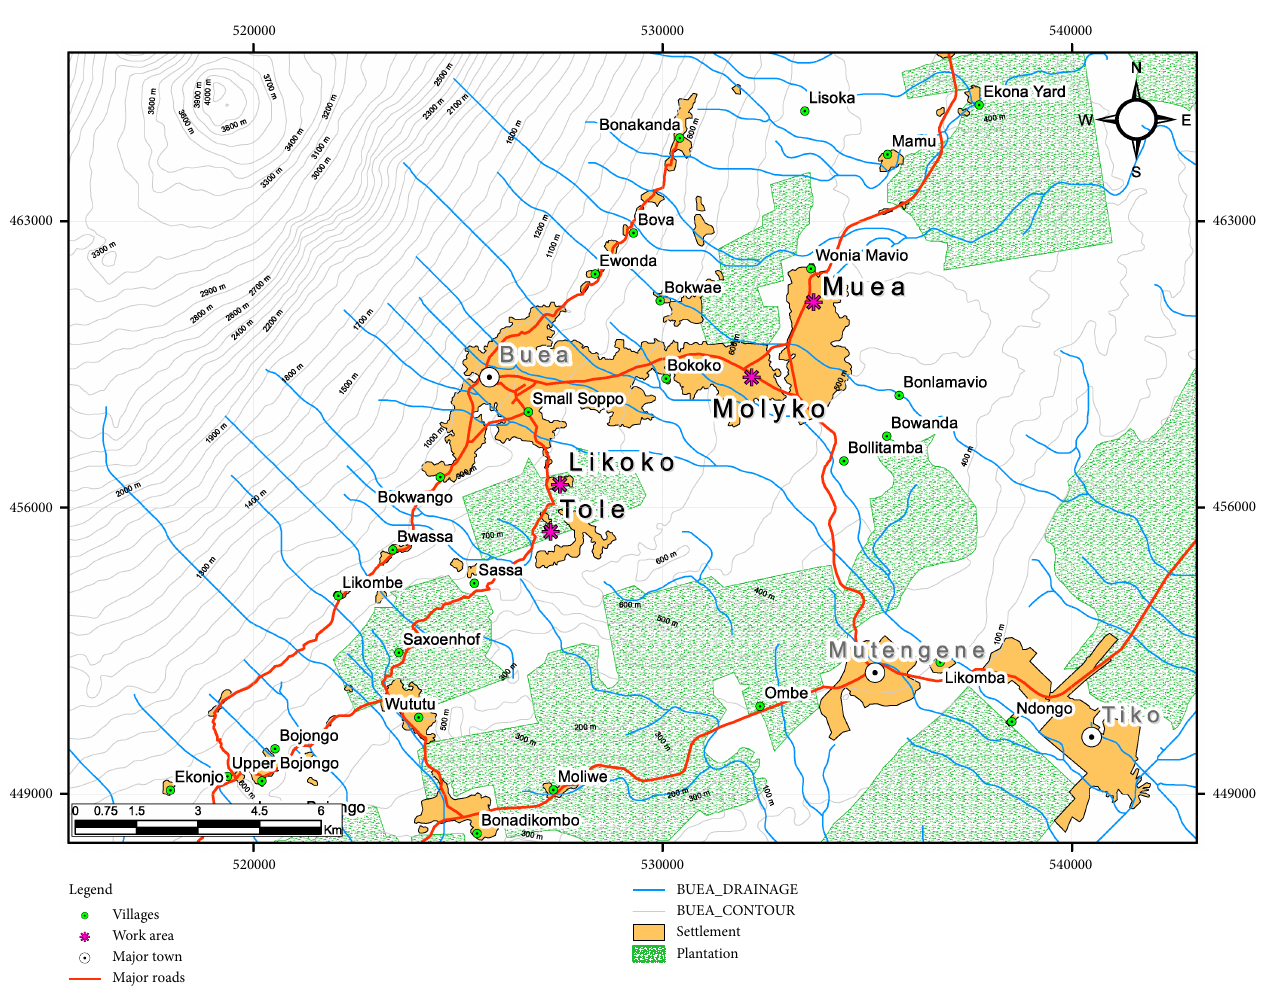
Figure 1: A map showing sampling